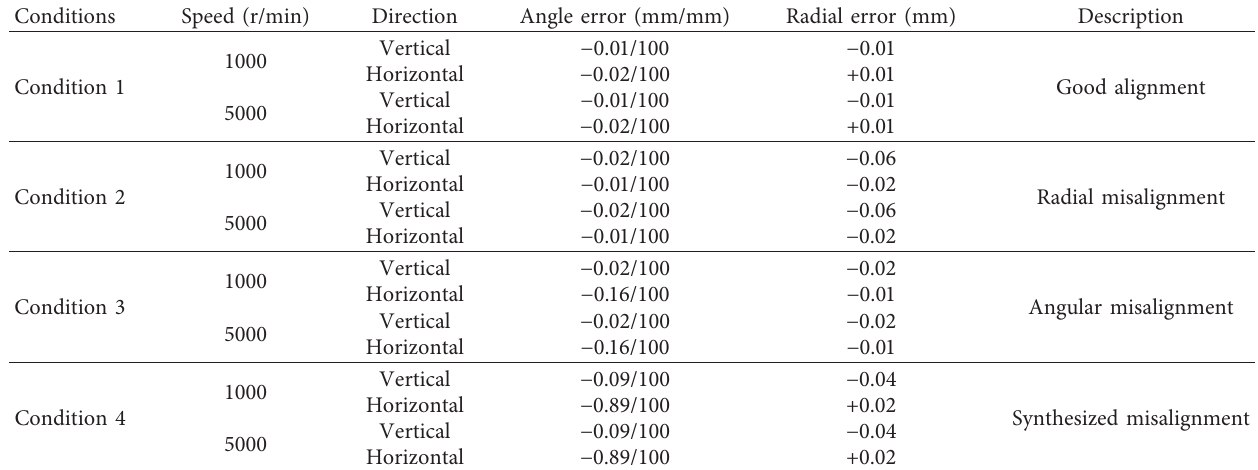
Figure 7: The test system of axis orbits. Table 2: Conditions of axis orbits’